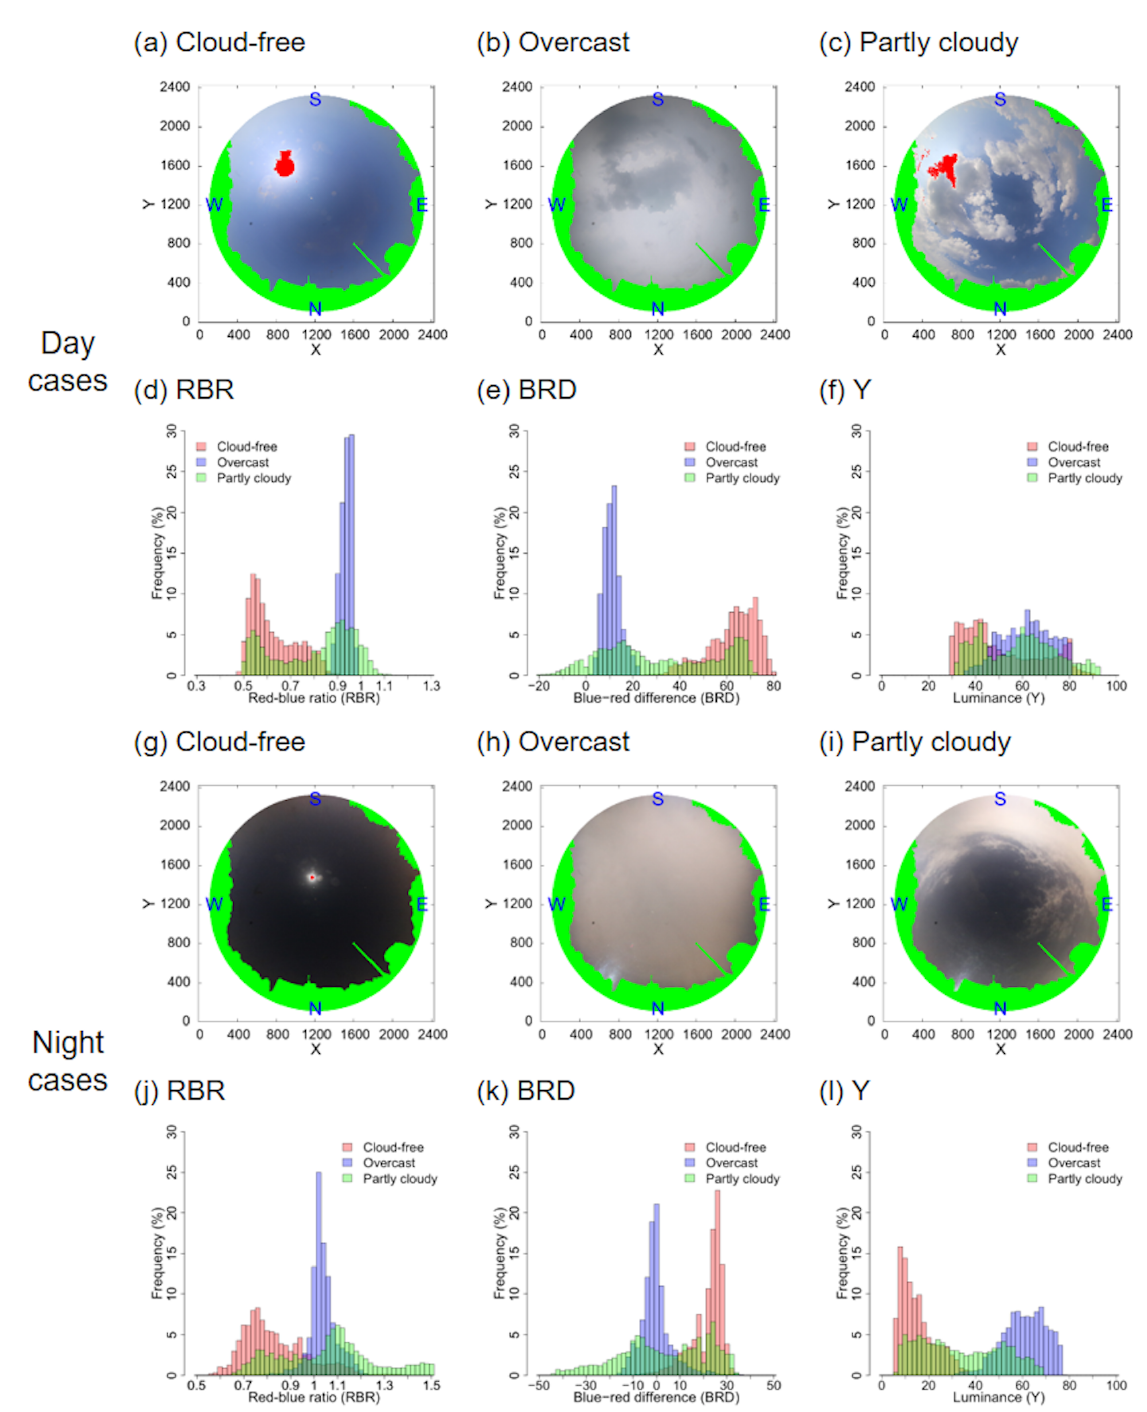
Figure 2. Distortion-corrected images and RBR (d, j) , BRD (e, k) , and Y (f, l) relative frequency distributions for cloud-free (0 tenths), overcast (10 tenths), and partly cloudy (5 tenths) cases at day and night. The daytime cloud-free (a) , overcast (b) , and partly cloudy (c) data were obtained at 14:00LST on 8 March, 12:00LST on 15 July, and 15:00LST on 28 September 2019. Cloud-free (g) , overcast (h) , and partly cloudy (i) nighttime data were obtained at 03:00LST on 24 January, 20:00LST on 18 February, and 22:00LST on 30 April 2019. The green and red areas are masked to remove surrounding masks (i.e., buildings, trees, and equipment) and light sources (i.e., the sun and moon),